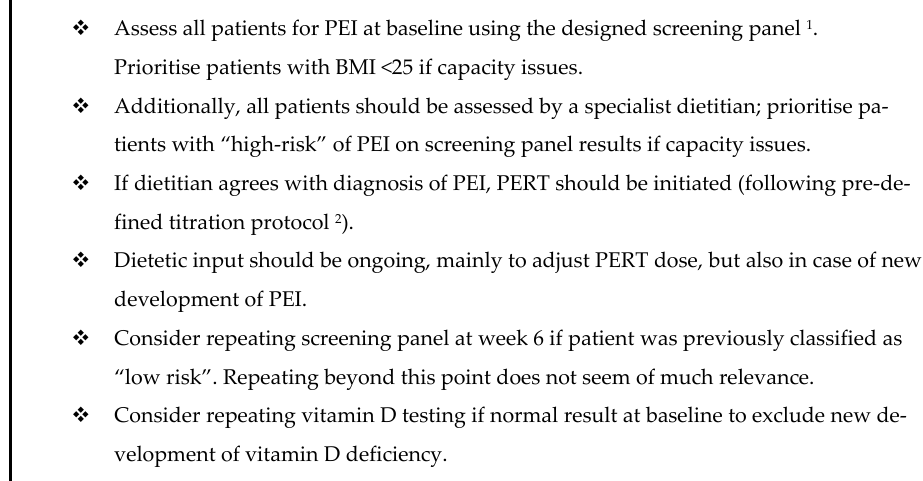
Figure 3. Recommendations. Abbreviations: BMI, body mass index; PEI, pancreatic exocrine insuffi ciency, PERT, pancreatic enzyme replacement therapy. 1 in Table 2. 2 in Supplementary Material S4.